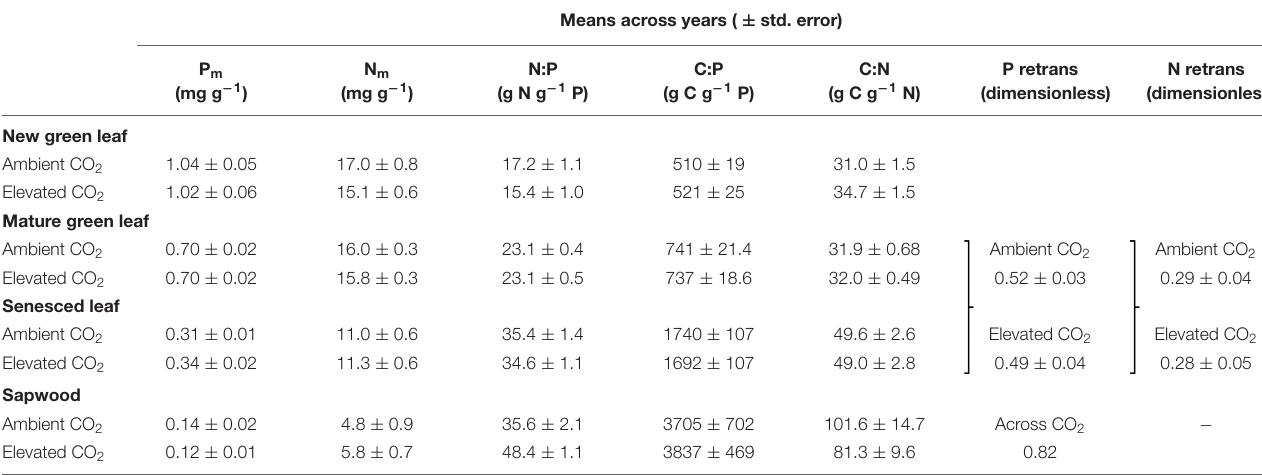
TABLE 2 | Means ± std. errors across years for mass-based phosphorus (P m ), mass-based nitrogen (N m ), the ratio between N and P (N:P), the ratio between C and P (C:P), the ratio between C and N (C:N) and the retranslocation fraction for P (P retrans) and N (N retrans) in ambient and elevated CO 2 in newly flushed and mature green leaves ( > 90 days since flushing), senesced leaves and sapwood. Means across years ( ± std. error)